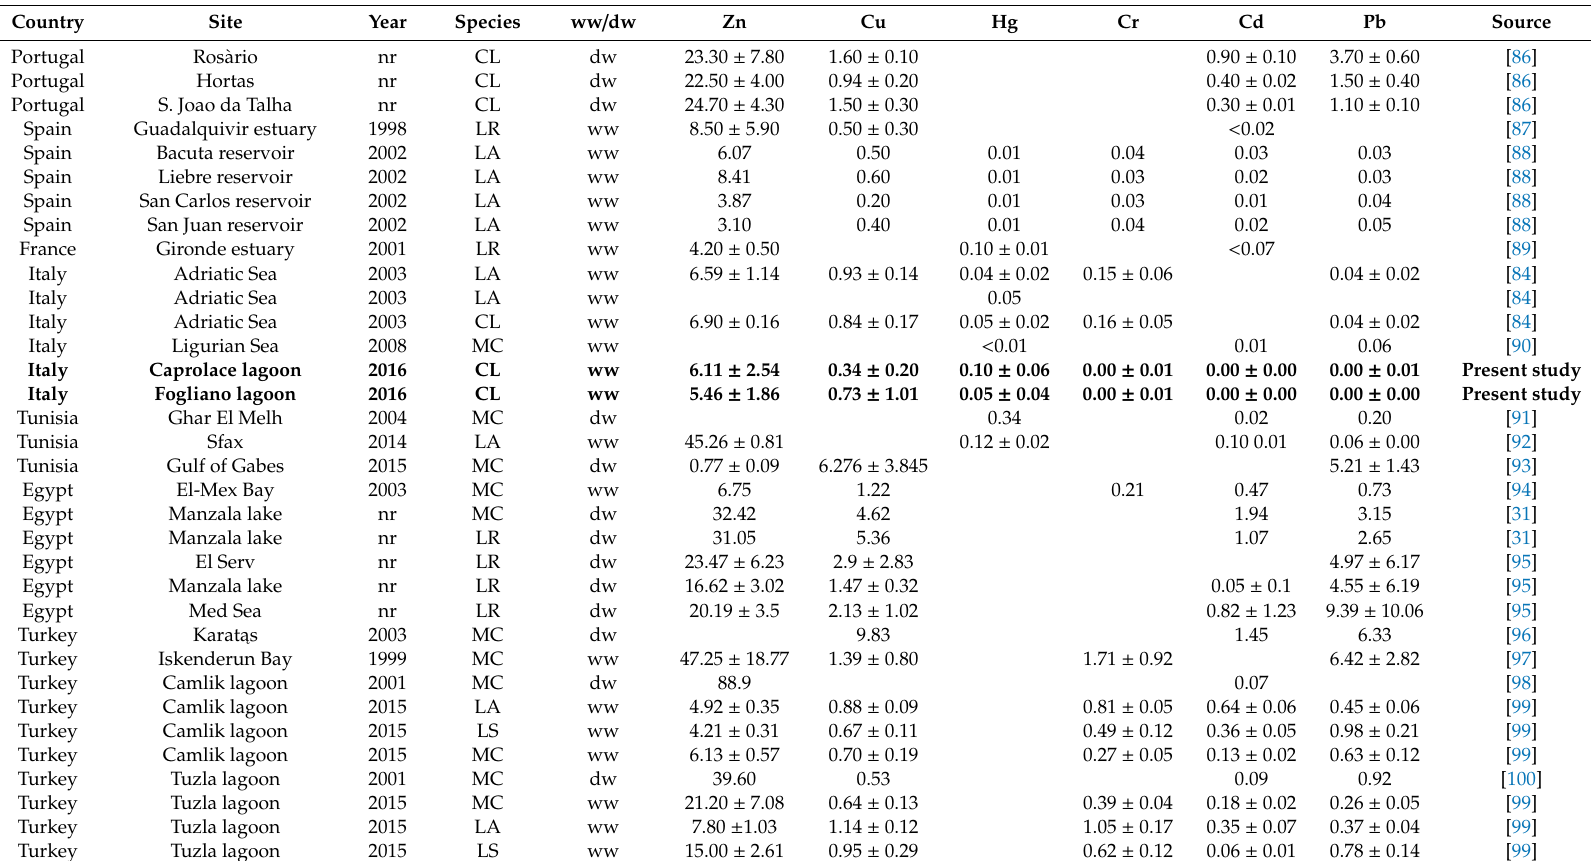
Table 6. Metal mean concentration ( ± SD where available) ( µ g g − 1 ) in grey mullets (Mugilidae) muscle tissue available in the scientific literature relative to sites from other Mediterranean locations, the Atlantic coast of Europe, and from the present study.